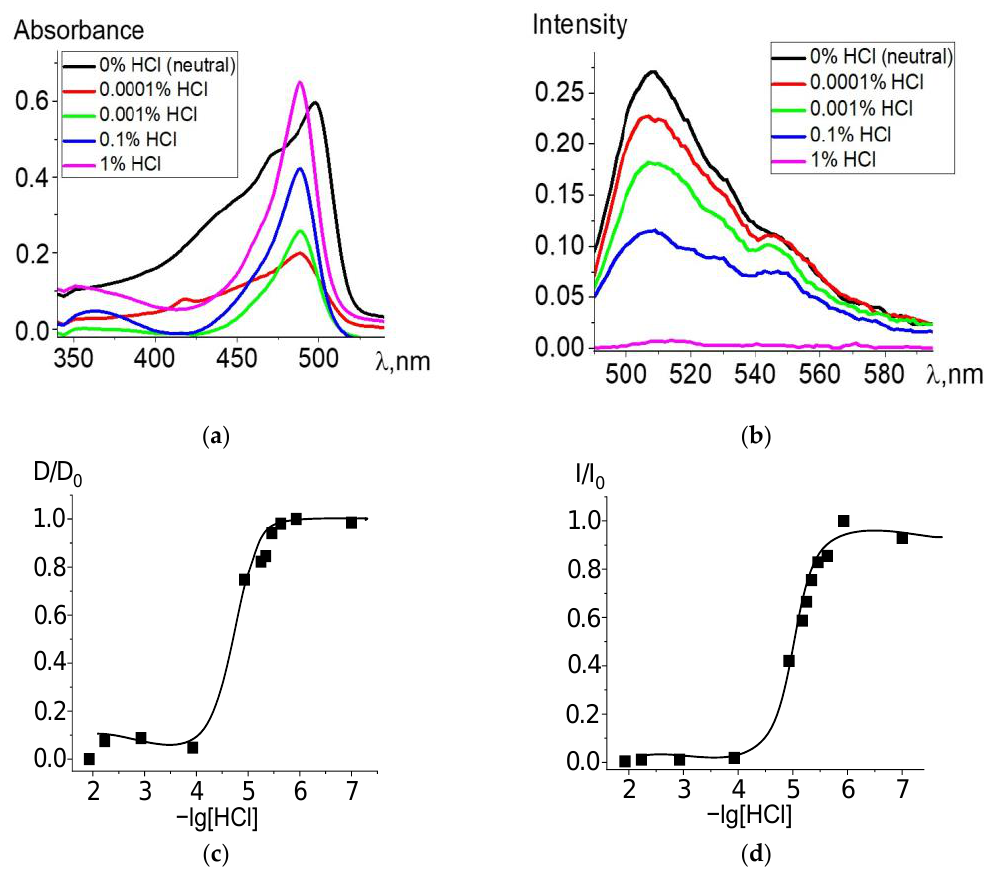
Figure 3. Changes in the absorption ( a ) and fluorescence ( λ ex = 470 nm) ( b ) spectra of Cd[Br 2 (CH 3 ) 4 dpm] 2 in ethanol upon the addition of 36% (11.6 M) HCl, in varying amounts. Experimental titration curves for the ground state S 0 (λ = 498 nm) ( c ) and excited state S 1 (λ = 508 nm) ( d ).